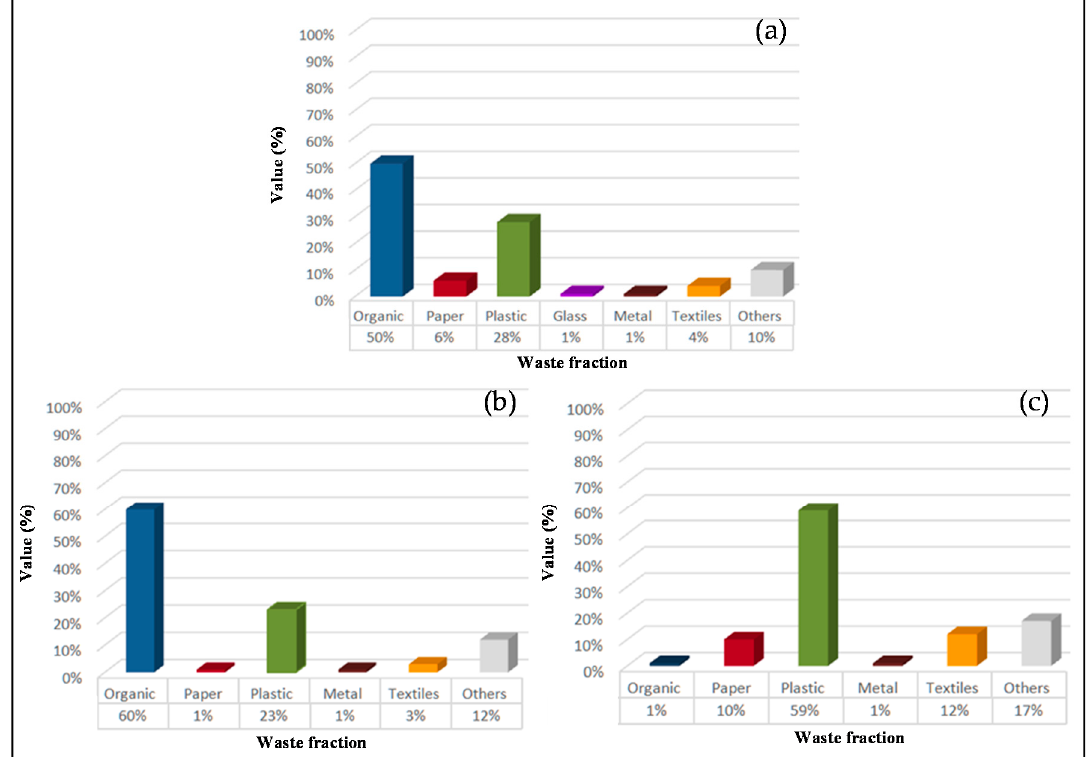
Figure 4. Real results obtained from quantification and characterization of urban solid waste generated at the University of Lome. ( a ) General composition of urban solid waste, ( b ) composition of waste from restaurants, ( c ) composition of waste from amphitheatres and classrooms.